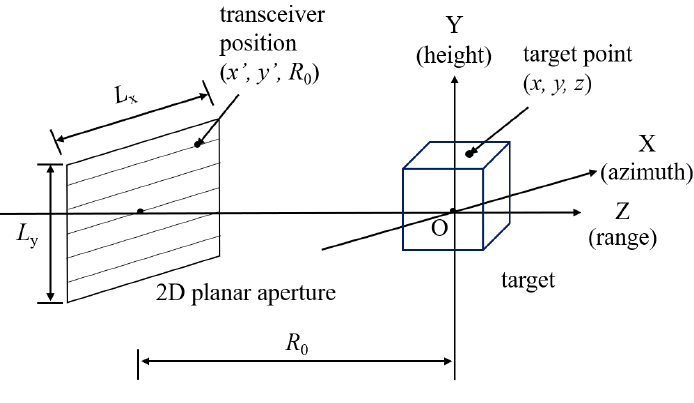
Figure 1. Close-range